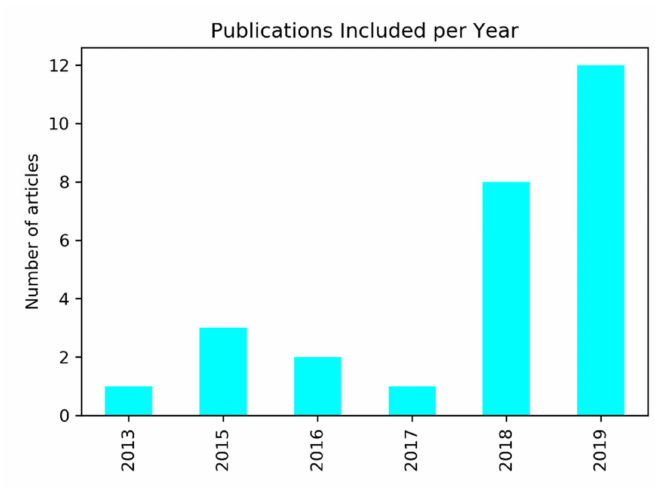
Figure 2. Number of articles included per year of